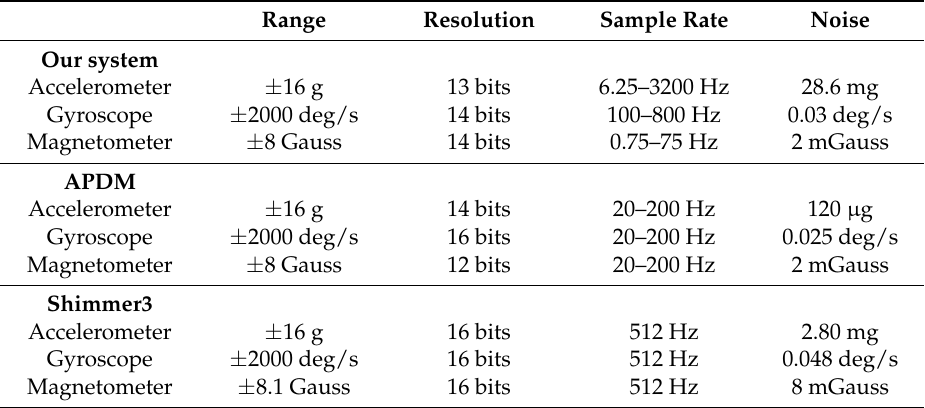
Table 1. Sensor characteristics of our system and other